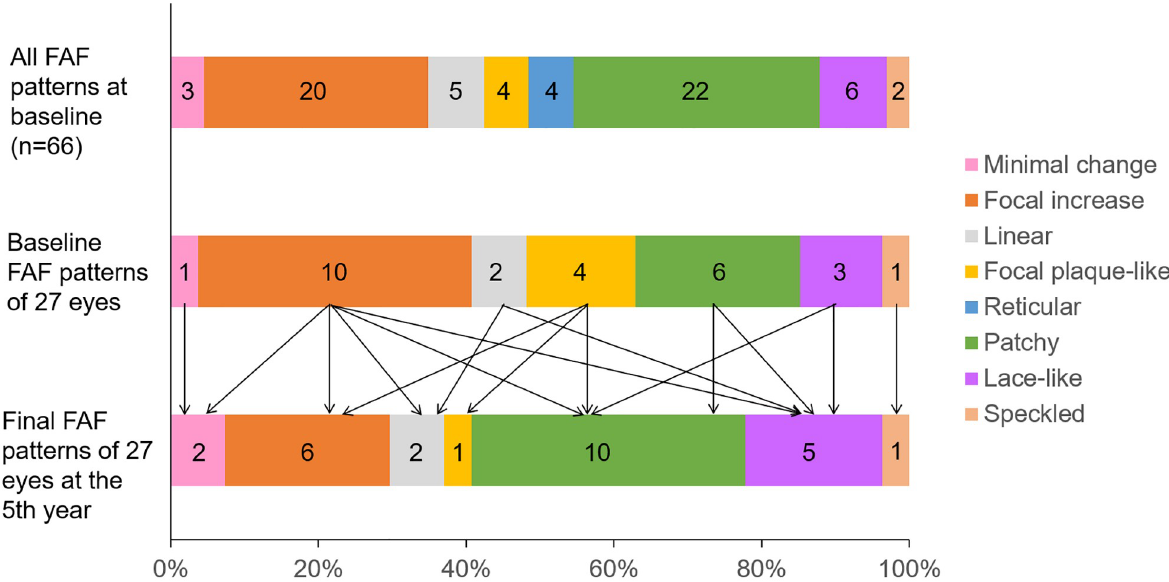
Fig 1. The proportions of FAF patterns. Top: all FAF patterns of 66 eyes at baseline. Middle: FAF patterns at baseline of 27 eyes which were followed-up during the 5 years. Bottom: the final FAF patterns of 27 eyes at the 5th year. The numbers within graphs show the actual number of the